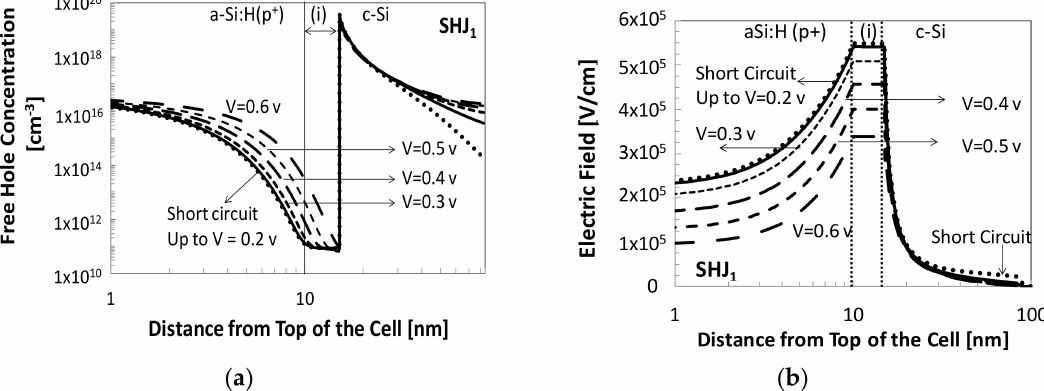
Figure 10. Simulated ( a ) hole concentration profile and ( b ) electric field distribution for cell SHJ 1 under illumination for different cell forward bias.